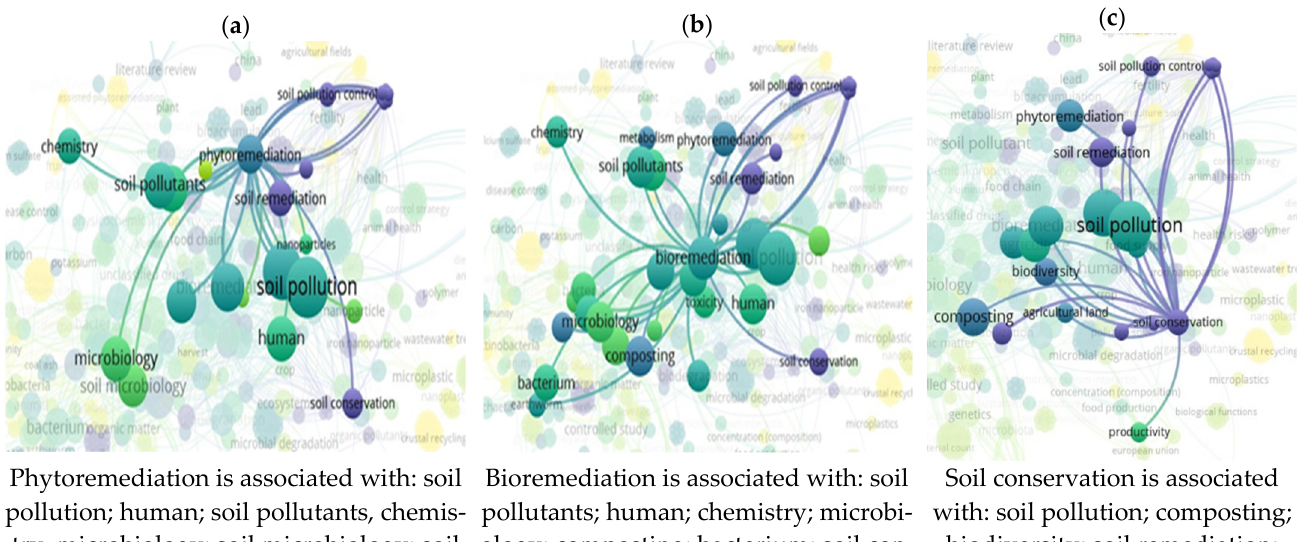
Figure 8. Analyzing Scopus results with the VOSviewer. The bioremediation ( a ) and biodegradation environmental ( b ) paradigms.